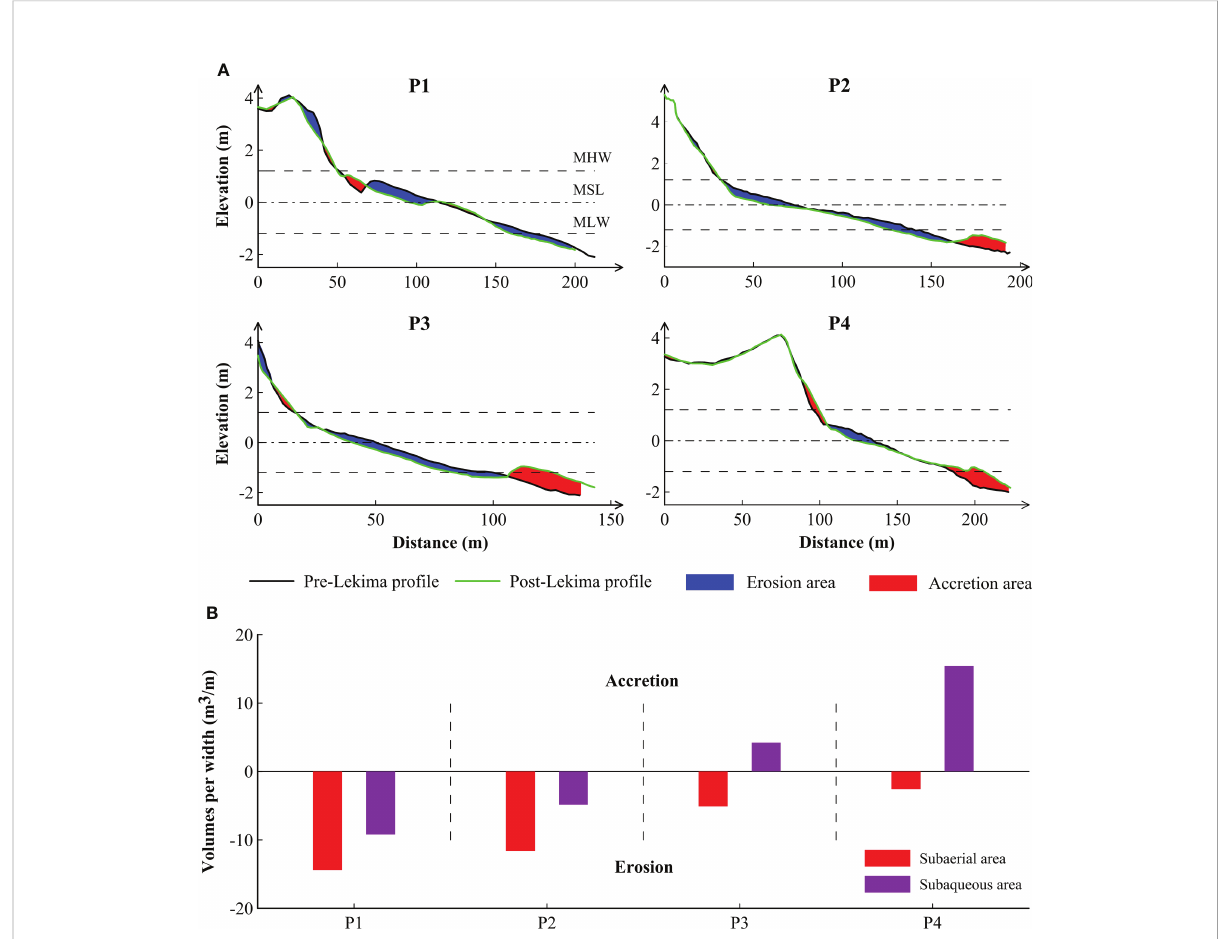
FIGURE 4 Topographic changes in beach pro fi les (locations can be found in Figure 1C) before and after Lekima (A) , MHW indicates the mean high water level, MSL indicates the mean sea level, and MLW indicates the mean low water level. Comparison of sediment budget of each beach pro fi le after Lekima (B)